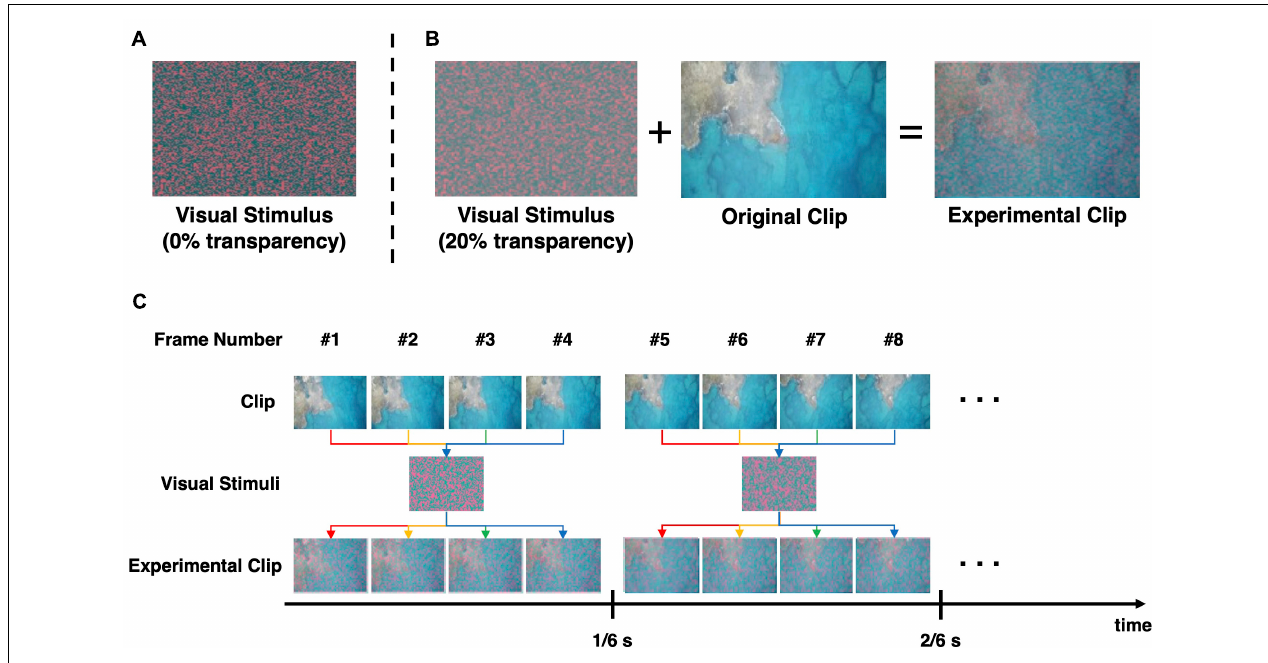
FIGURE 1 | Procedure to generate the experimental videos employed in this study. (A) The chromatic random-noise-like visual stimulus. (B) The conceptual procedure of generating the experimental clip. The visual stimulus was applied with 20% transparency and then superimposed on the original clip. (C) The overlaying process to create flickering effect for evocation of SSVEP response. The visual stimulus that was overlapped on the clip changed every 1/6 s, so that the resultant video flicker at 6 Hz. Note that the frame rate of the experimental video was 24 frame/s, and the same visual stimulus was maintained for subsequent four